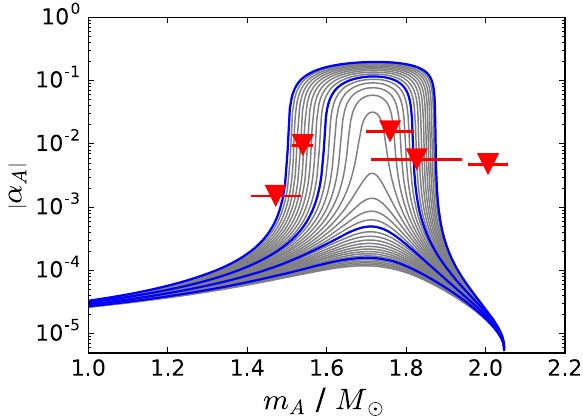
FIG. 1. Illustration of spontaneous scalarization in the DEF gravity, in comparison to individual binary-pulsar limits, for a NS with EOS SLy4 and j α 0 j ¼ 10 − 5 . The blue curves correspond to (from top to bottom) β 0 ¼ − 4 . 5 ; − 4 . 4 ; − 4 . 3 , and − 4 . 2 ; the grey curves in between differ in β 0 in steps of 0.01. We indicate with triangles the 90% C.L. upper limits on the effective scalar coupling j α from the individual pulsars listed in Table I. We A j ∼ 1 . 7 M can clearly see a scalarization window at m ⊙ A